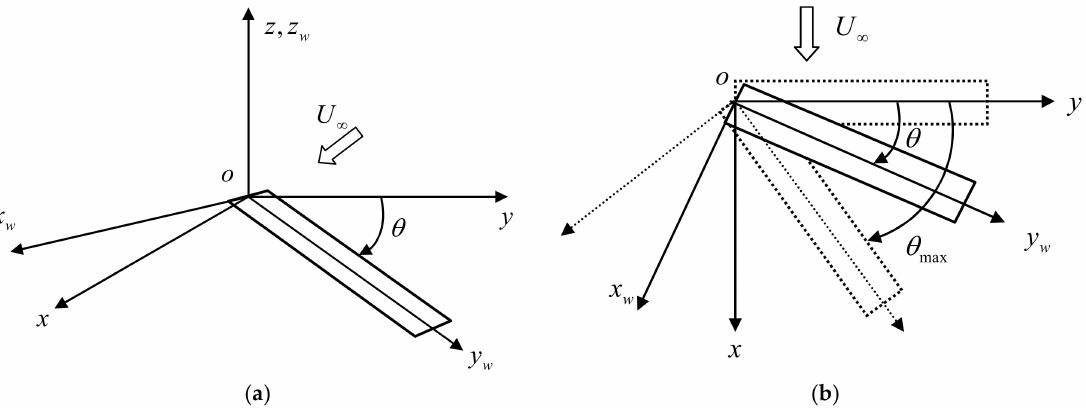
Figure 1. Schematic of a variable swept wing and the coordinate frames. ( a ) Stereogram description. ( b ) Planform